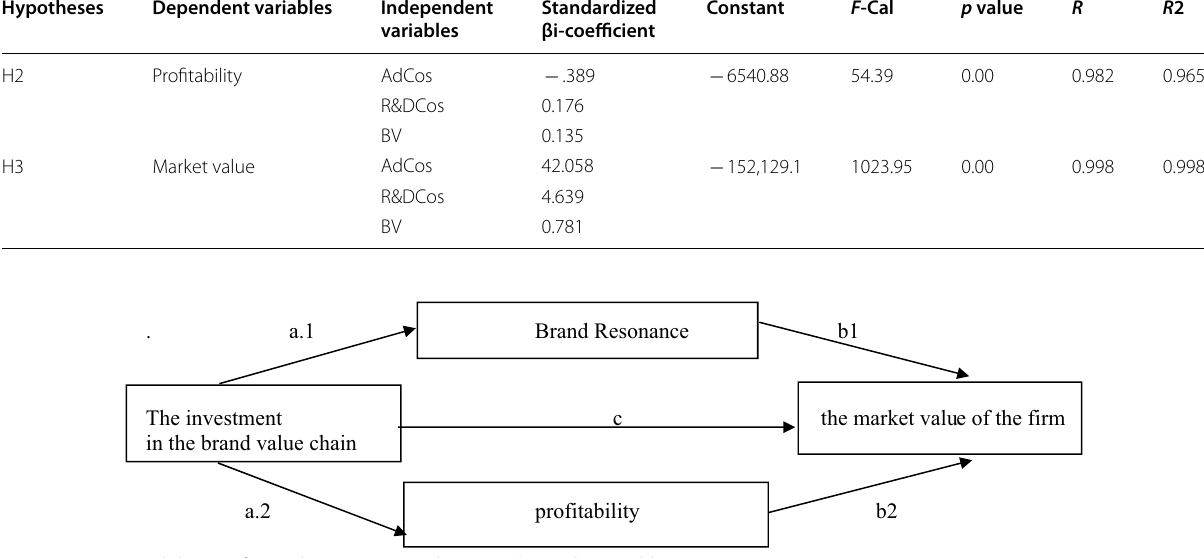
Fig. 3 Conceptual diagram for mediation processes between the study’s variables